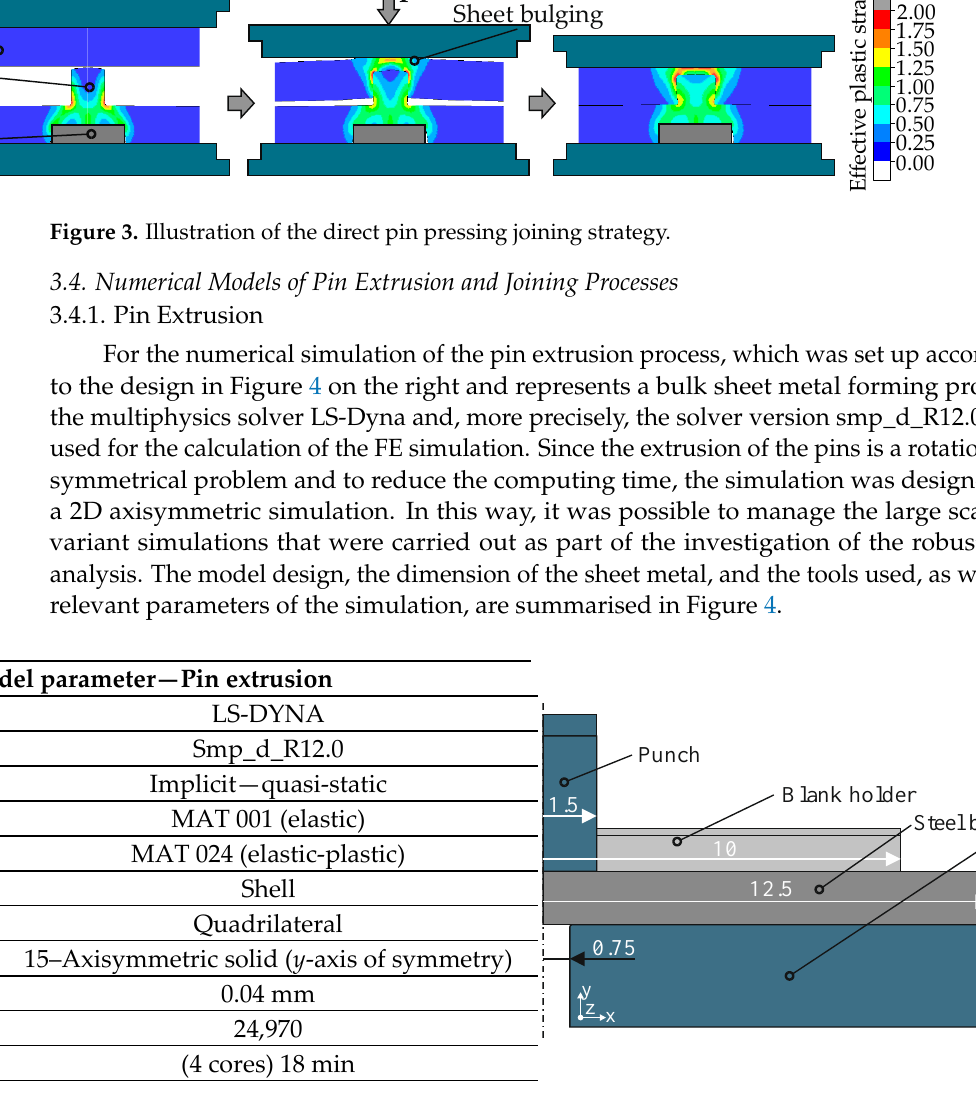
Figure 4. Relevant parameters of the FE-Simulation of the pin extrusion process as well as the FE-model design with the initial dimensions.